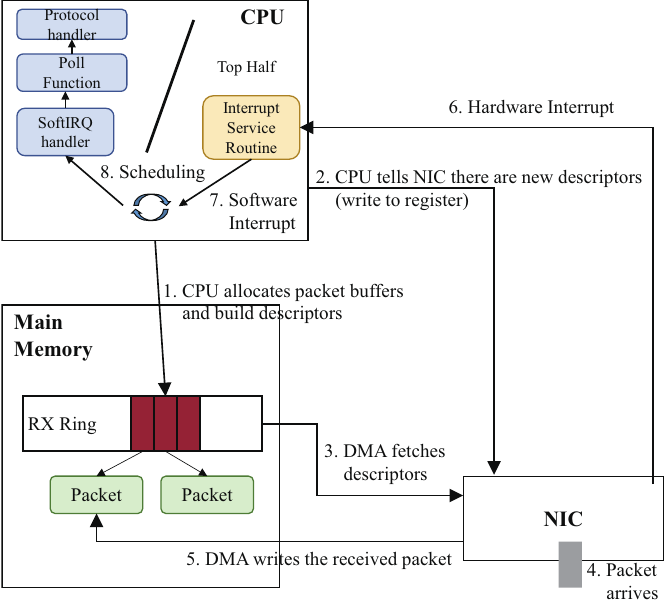
Figure 2. Network processing routines in Linux consist of dynamic memory access (DMA) and CPU